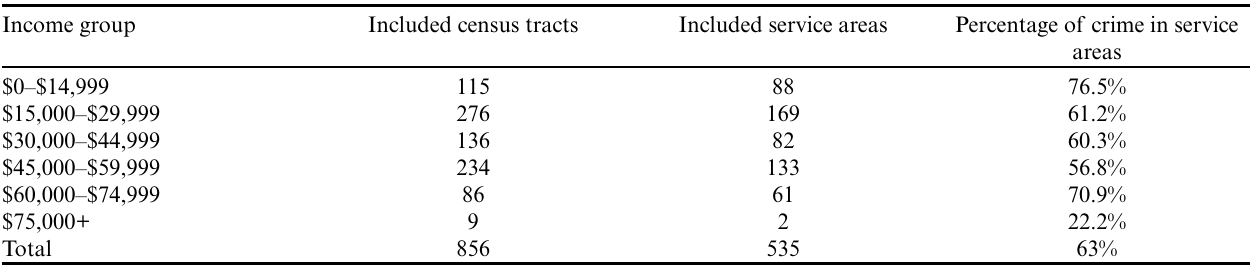
Table 2. Amount of crime in service areas by income